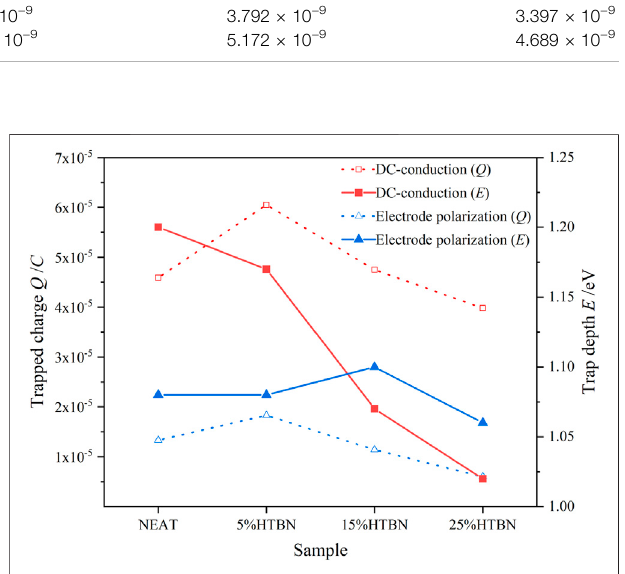
FIGURE 11 | Trap characteristics of DC conductance and electrode polarization of samples with different rubber